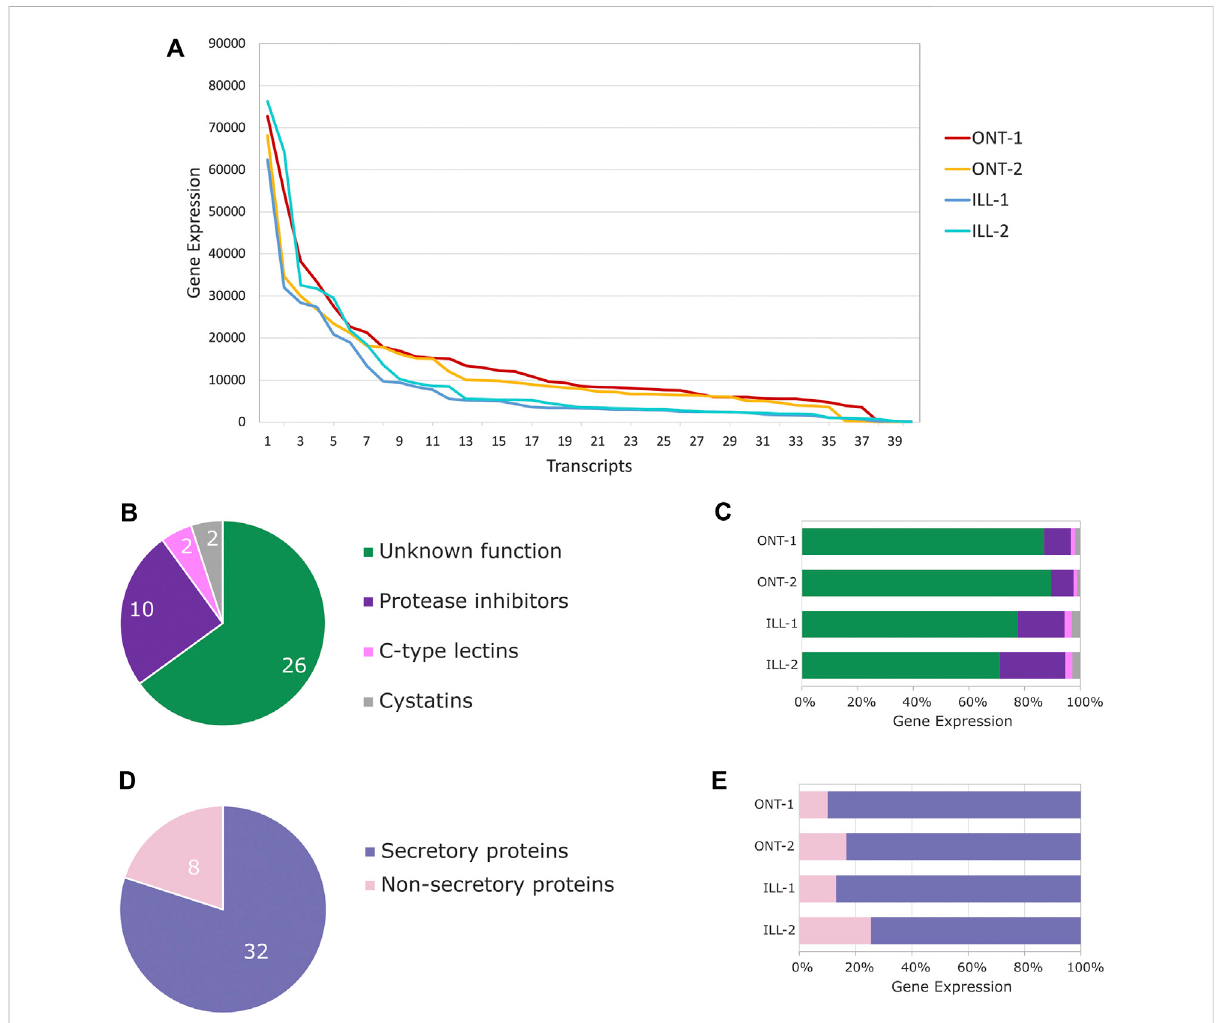
FIGURE 4 Geneexpressionandgenefunctionin S.punctum accessoryglandgenes.Analysisof40highestexpressedgenesin S.punctum AGsshowed (A) a high level of congruence in overall gene expression pattern between ONT read counts and Illumina Transcripts per Million (TPM) (B) 26 genes of unknown function , 10 protease inhibitors, and 2 each of C-type lectins and cystatins, (C) genes of unknown function were the highest expressed gene category, followed by protease inhibitors, in both ONT and Illumina samples (D) 32 genes encoding secretory proteins and eight genes encoding non-secretory proteins, and (E) genes encoding secretory proteins accounted for the majority of expression in both ONT and Illumina